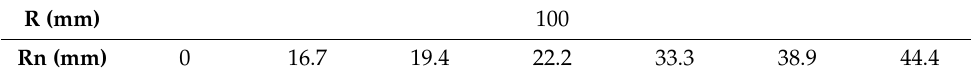
Figure 9. ( a ) Specimen’s geometry in the Nakajima test, ( b ) Schematic of the Nakajima acquisition system. Table 4. Dimensions of the specimen’s geometry in the Nakajima test.